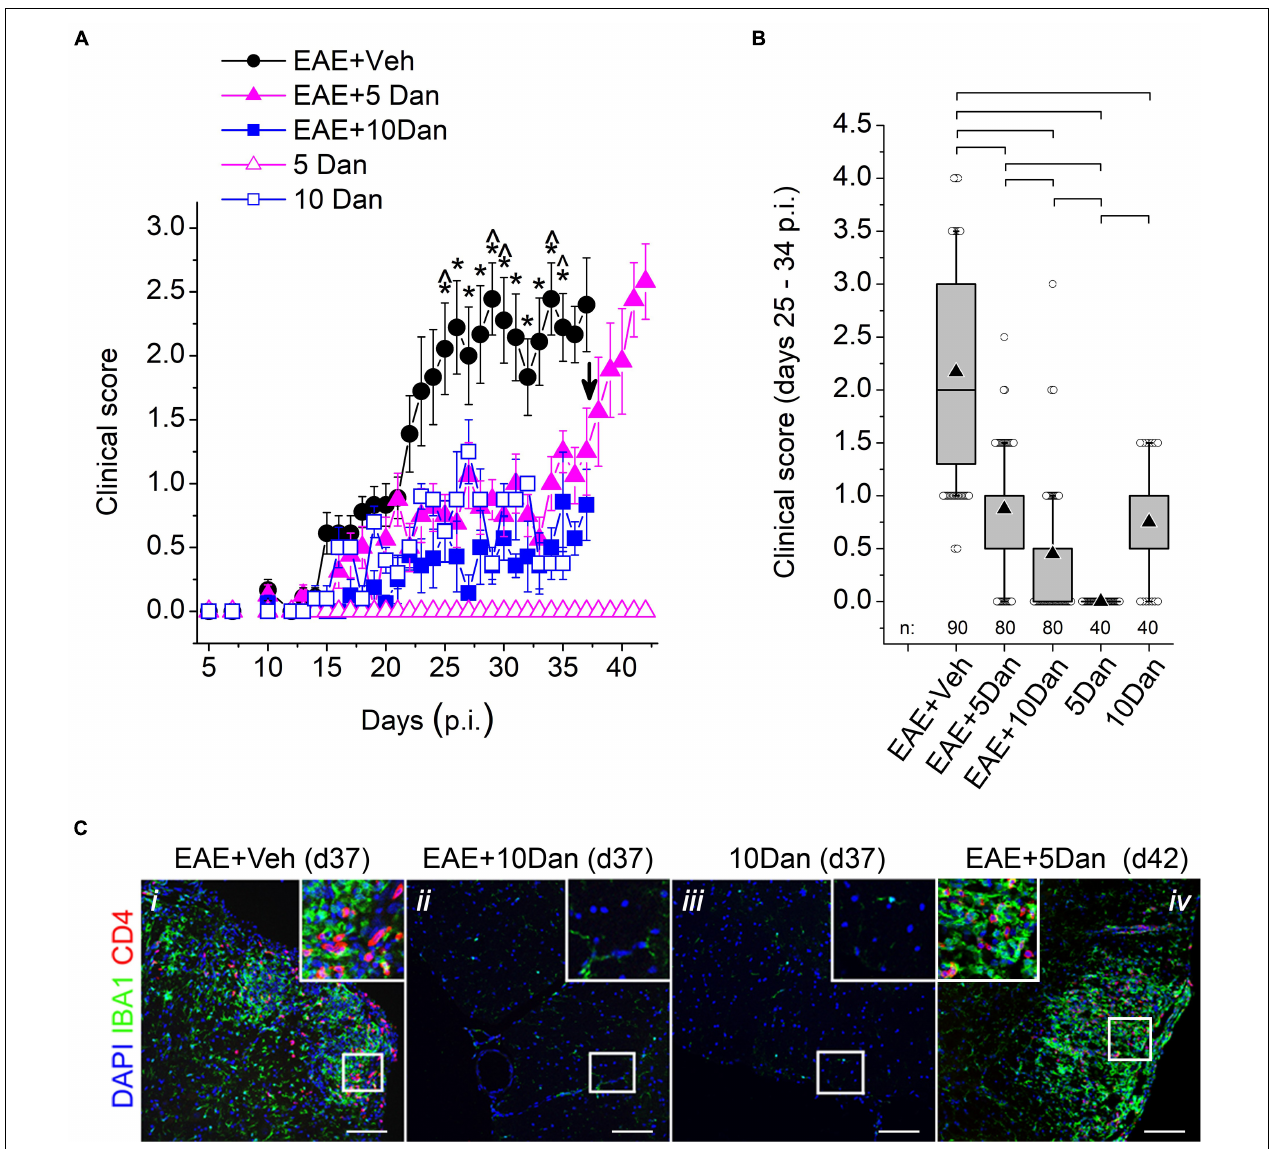
FIGURE 1 | Dantrolene alleviates clinical symptoms and reduces CNS inflammation in EAE mice. (A) Daily EAE clinical scores of mice injected with vehicle (EAE + Veh; n = 9), 5 mg/kg dantrolene (EAE + 5 Dan; n = 8), 10 mg/kg dantrolene (EAE + 10 Dan; n = 8), and control groups mice in which EAE was not induced injected with 5 mg/kg dantrolene (5 Dan; n = 5 before day 16 and n = 4 on and after day 16), or 10 mg/kg dantrolene (10 Dan; n = 5 before day 24 and n = 4 on and after day 25). Injections of vehicle or dantrolene solutions began at the time of immunization and were delivered daily after that. Data were collected during one experiment and are shown as mean ± SE; n, number of animals in the group. Asterisks denote significant difference between mean scores in the EAE + Veh group and mean scores in EAE + 5 Dan; EAE + 10 Dan, and 5 Dan groups; circumflexes denote significant difference between average scores in the EAE + Veh group and those in all other groups (two-way repeated-measures ANOVA with Bonferroni correction; p < 0.05). Beginning on day 37 p.i., mice in the EAE + 5 Dan group were injected with vehicle alone (indicated with an arrow). Note the rapid increase in clinical scores after cessation of administration of 5 mg/kg dantrolene. (B) Box charts of clinical scores recorded from day 25 p.i. until day 34 p.i. in five treatment groups. Data are from the same treatment groups shown in (A) . Brackets indicate that differences between treatment group means are significant ( p < 0.01; one-way ANOVA with Bonferroni correction). In the box charts, the boundary of the box closest to zero indicates the 25th percentile, a horizontal line within the box marks the median, a black up-pointing triangle within the box marks the mean, and the boundary of the box farthest from zero indicates the 75th percentile. Whiskers above and below the box indicate the 10th and 90th percentiles. Open circles above and below the whiskers indicate outliers outside the 10th and 90th percentiles. The total combined number of measurements per treatment group (n) are shown at the bottom of the graph. (C) Spinal cord sections stained for IBA + and CD4 + infiltrating cells obtained on day 37 p.i. from EAE mouse injected daily with vehicle (EAE + Veh; panel i ), EAE mouse injected daily with 10 mg/kg dantrolene (EAE + 10 Dan; panel ii ), and control mouse injected with 10 mg/kg dantrolene (10 Dan; panel iii ). Right panel (EAE + 5 Dan; panel iv ) shows spinal cord section obtained on day 45 p.i. from EAE mice injected daily with 5 mg/kg dantrolene from day 0 to day 37 p.i. and with vehicle alone after that. IBA1 is a marker for microglia and infiltrating macrophages; CD4 is a marker for infiltrated CD4 + T cells; nuclei were contrasted with DAPI. Representative images from spinal cord sections from four randomly selected mice, which were examined for each condition. Scale bars, 100 µ m. Boxed area at the top of each panel is an expended boxed area shown in the middle of the panel. Each boxed area is 100 × 100 µ m.